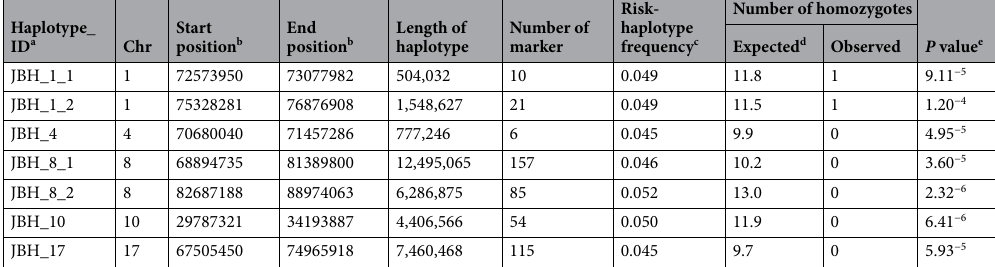
Table 1. Regions with homozygous haplotype deficiency and carrier frequencies of potential lethal haplotypes in Japanese Black cattle. a Haplotype IDs consist of “JBH” for “Japanese Black haplotype,” followed by chromosome number. b Positions are based on the UMD3.1 assembly of the bovine genome. c Haplotype frequency was calculated in 4,843 individuals. d The expected number of homozygous individuals for a haplotype was calculated using the frequencies of haplotypes and carriers assuming random mating. e P value was calculated using the frequencies of homozygotes and carriers with a binomial test.